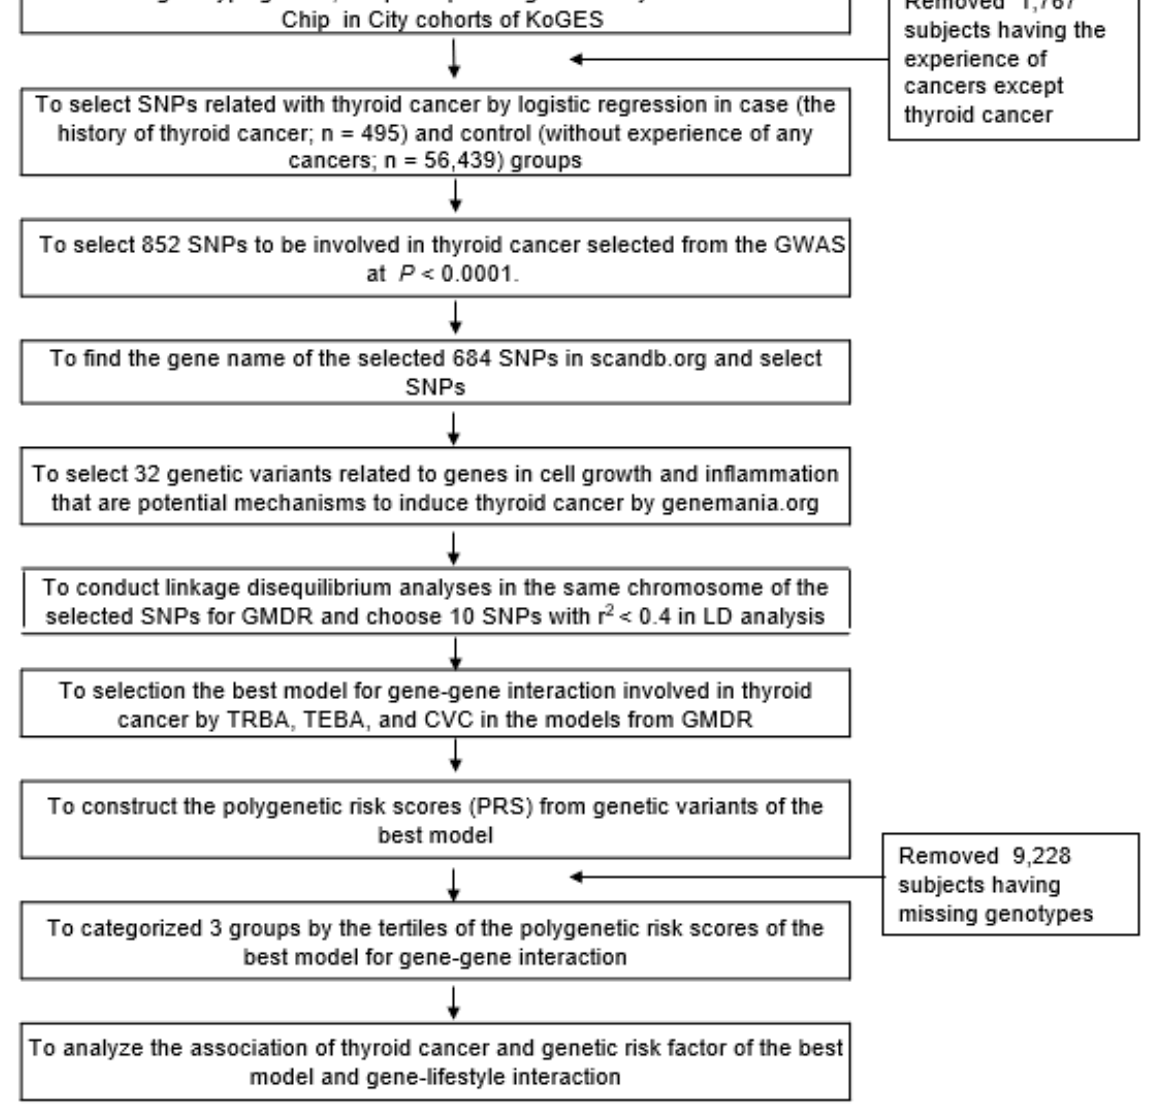
Figure 1. The flow chart for the generation of polygenetic risk scores that influence thyroid cancer risk.